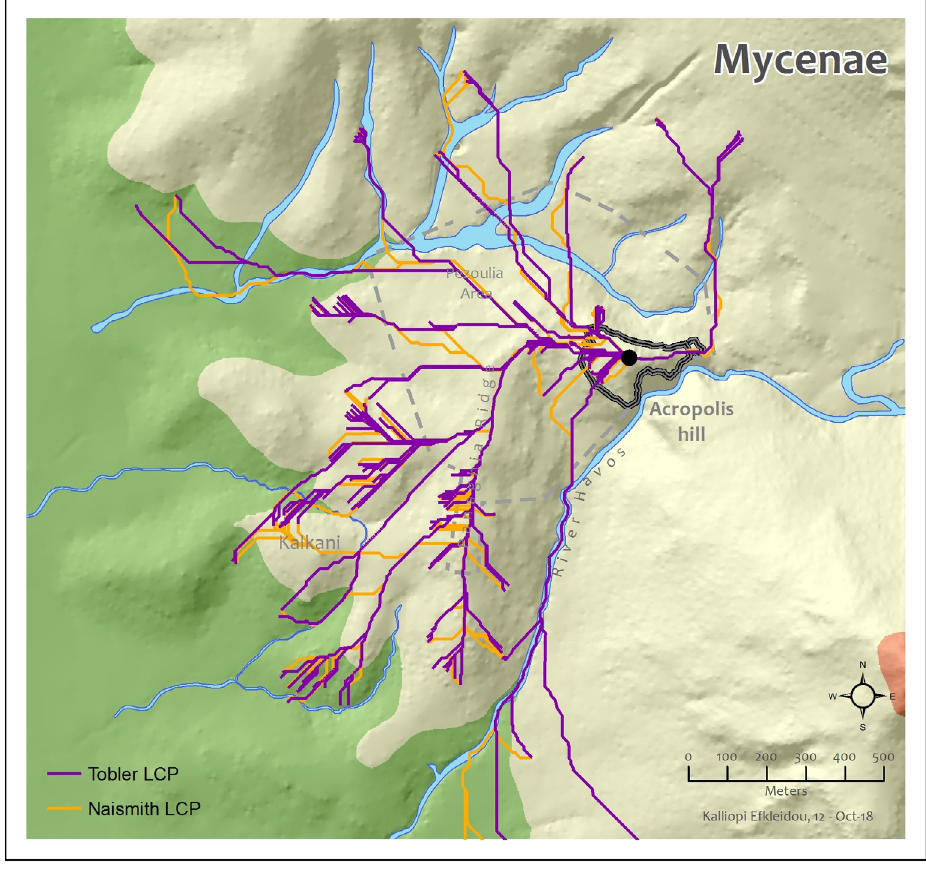
Figure 3. The LCPs based on slope costs only and the extant Mycenaean road (“highway”)